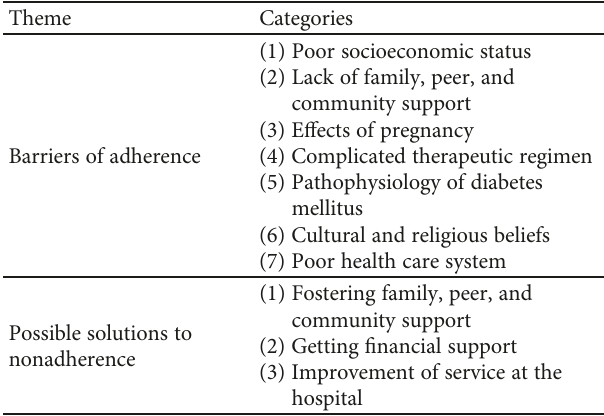
Table 2: Summary of categories identi fi ed under barriers and possible solutions to nonadherence to antidiabetic